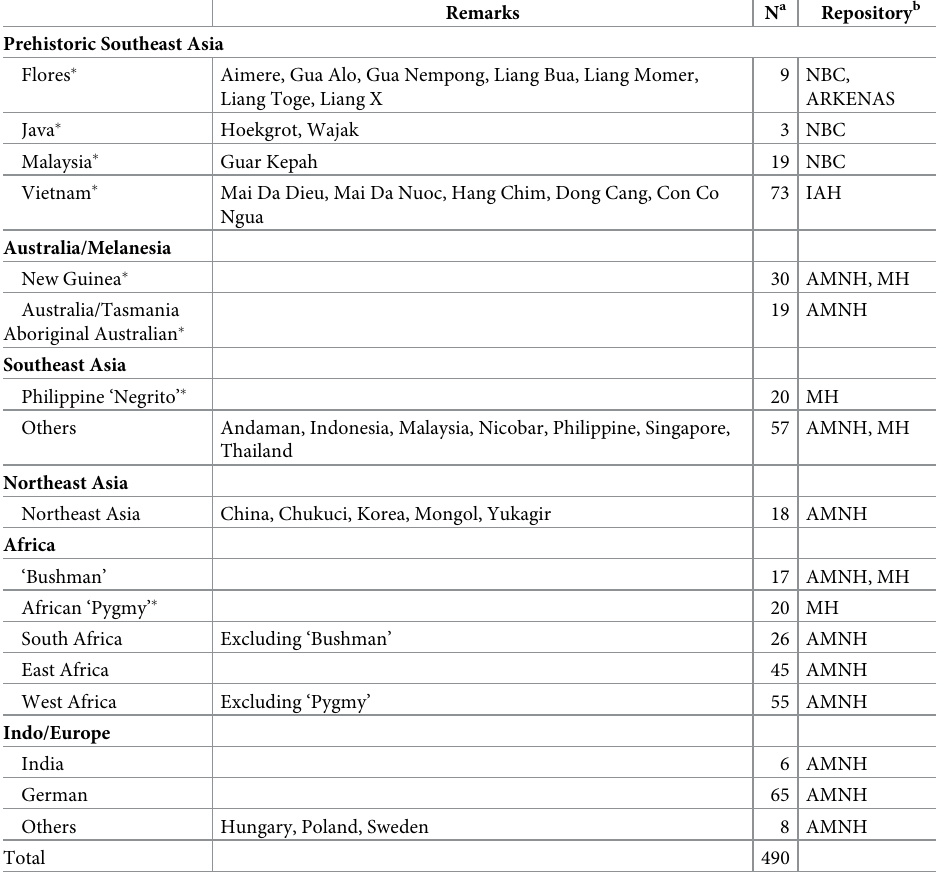
Table 2. Comparative Homo sapiens sample (see Fig